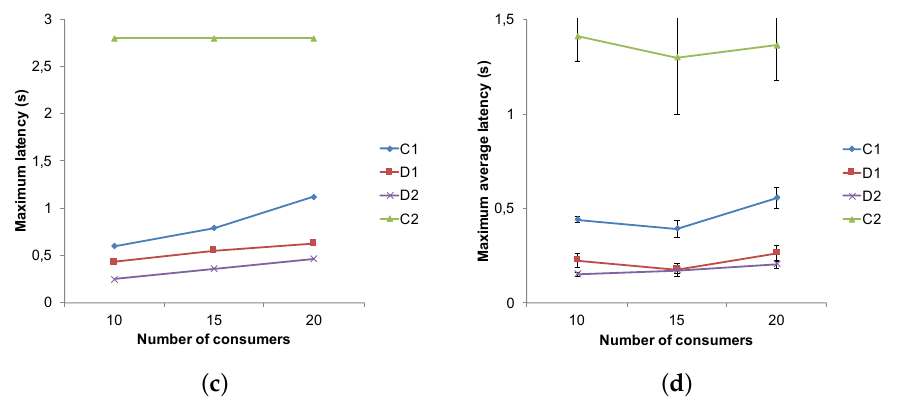
Figure 6. Performance for variable number of consumers. ( a ) Success rate; ( b ) average latency; ( c ) maximum latency; ( d ) maximum average latency.